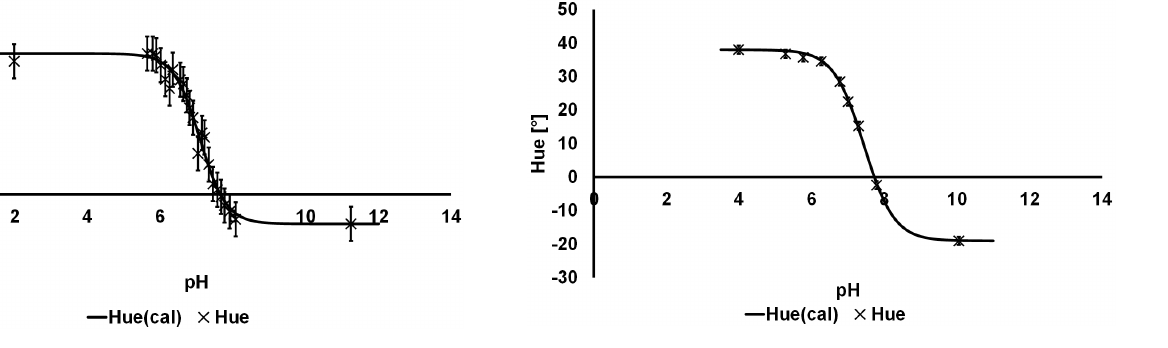
Figure 6. Hue data (mean value of 10 measurements) depending on pH values. PhR diluted in a ratio of 1:10 in SPPB. The fitting pa- rameters are the following: pK a = 7 . 13, α = 1 . 20 and 2 σ = 4 . 55 ◦ .